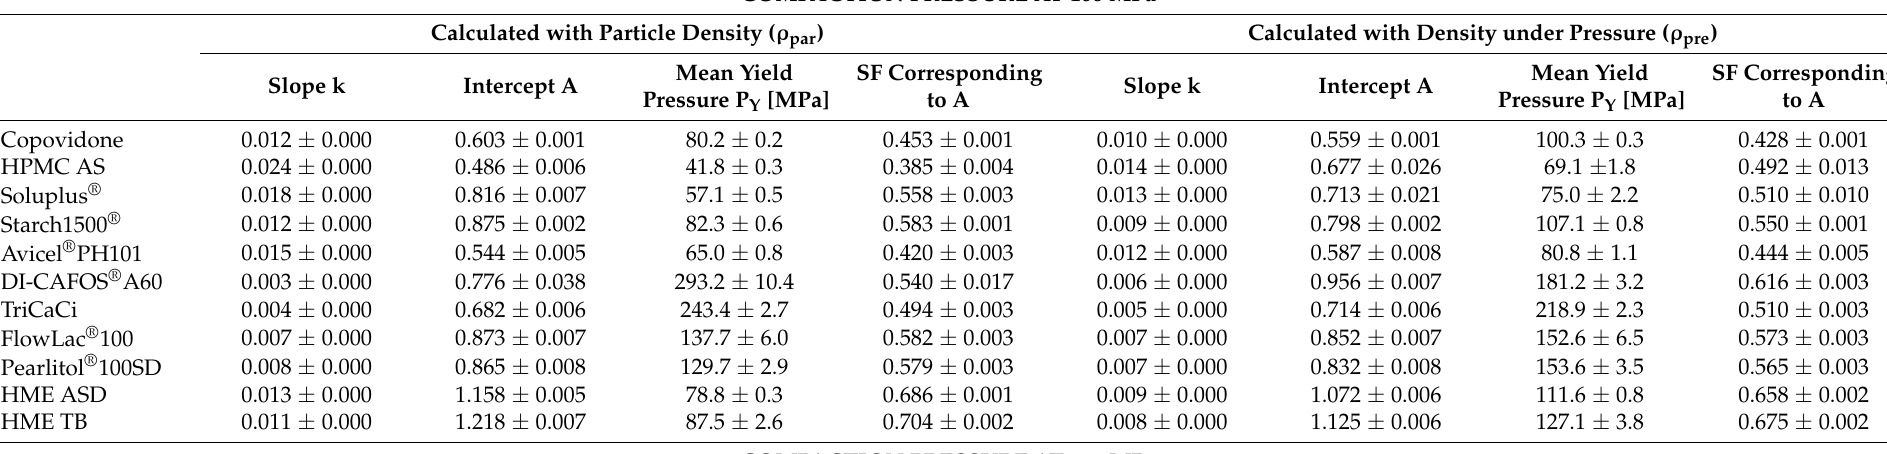
Table 3. Calculated parameters from the Heckel analysis for all excipients and HME ASD and TB compressed at 100 MPa and 300 MPa (n.a. = not applicable, no sufficient